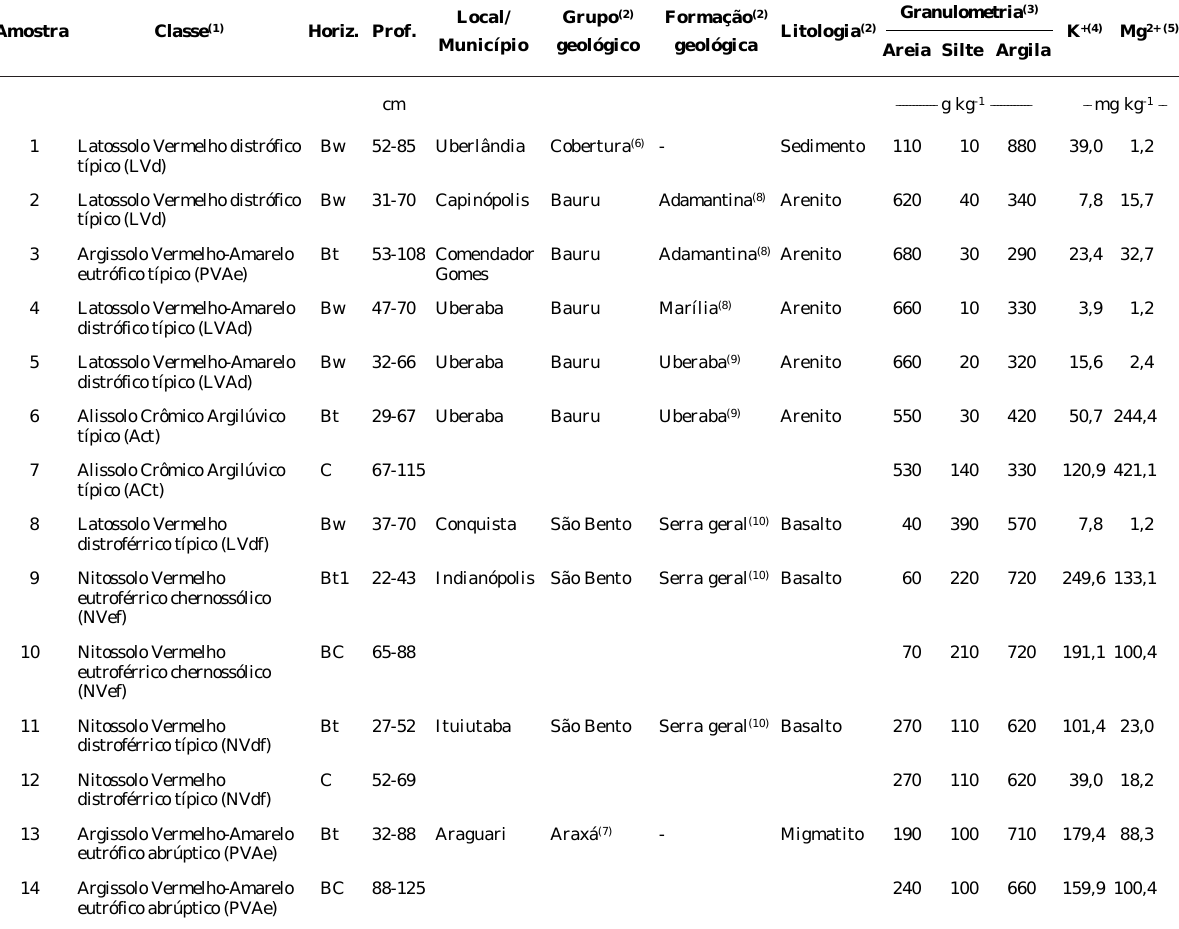
(1) Segundo Embrapa (1999). (2) RADAMBRASIL (1983); (3) Embrapa (1997). (4) Mehlich-1; (5) KCl 1 mol L -1 (Pavan et al., 1992). (6) Coberturas Detrito-Lateríticas Terciárias. (7) Unidades pré-cambrianas compostas de micaxisto, gnaisses granatíferos, migmatitos e granitos. (8) pacote sedimentar com camadas predominantemente areníticas e secundariamente lamíticas, comglomeráticas, sílticas e argilíticas. (9) Pacote sedimentar interestratificado de arenitos muito finos, médios e raramente grosseiros com camadas de siltitos, argilitos e arenitos conglomeráticos, com ocorrências cíclicas, matriz arenítica esverdeada agregando grânulos de basalto, argilito, magnetita e nódulos de calcário e um conglomerado basal com matriz polimítica. (10) Sucessão de derrames de composição básica, com intercalações lenticulares de arenitos (Botucatu)